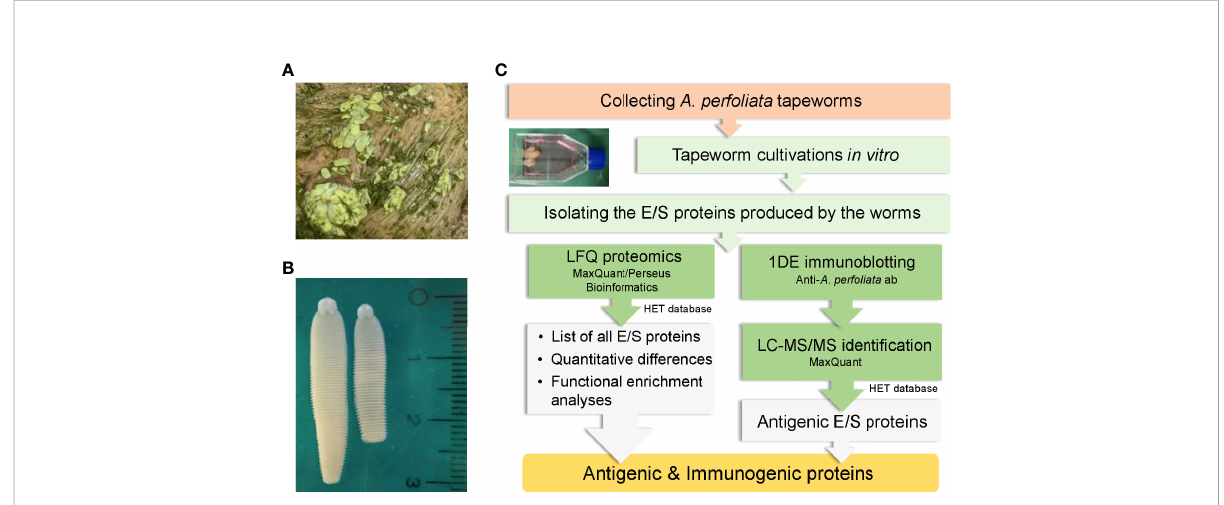
FIGURE 1 Collecting and culturing A perfoliata tapeworms to produce E/S proteins in vitro for proteomics and immunoproteomics. (A) worms before collection (B) macroscopic morphology of A perfoliata (C) A work fl ow illustrating different stages used for producing in vitro E/S proteins and their quantitative identi fi cation and screening for antigenic proteins using horse antisera containing antibodies to A perfoliata